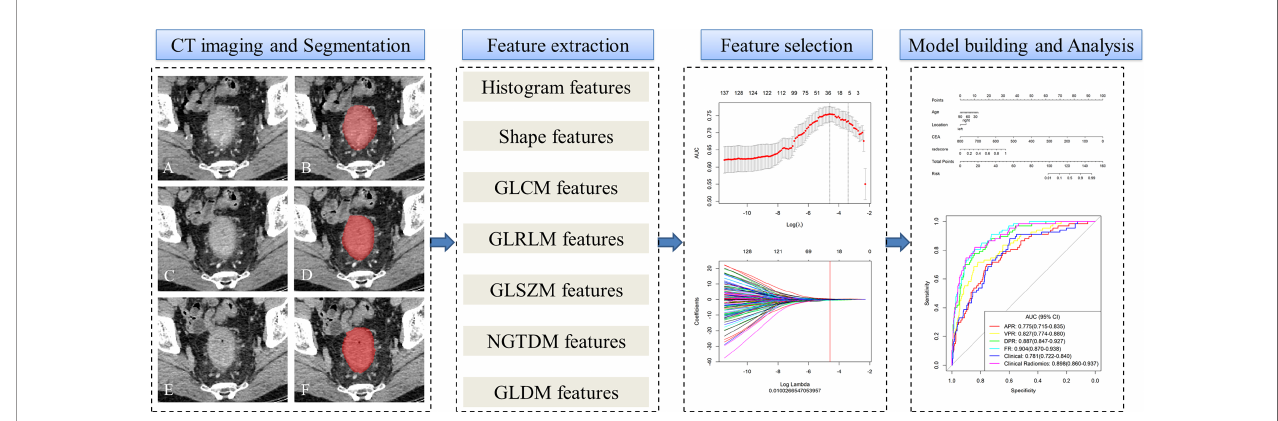
FIGURE 2 | Work fl ow of microsatellite instability (MSI) prediction building and analysis. The tumors were segmented on arterial phase (A, B) , delayed phase (C, D) and venous phase (E, F) CT images to form volumes of interest (VOIs). One thousand and thirty-seven quantitative radiomics features were extracted from each patient. The least absolute shrinkage and selection operator (LASSO) was used to select the features. Multivariate logistic regression was used to build radiomics, clinical, and clinicoradiomics combined models for MSI prediction. Finally, the radiomics signature and clinical factors were incorporated into a nomogram for individual evaluation. Receiver operating characteristic curves were used to evaluate the clinical usefulness of the